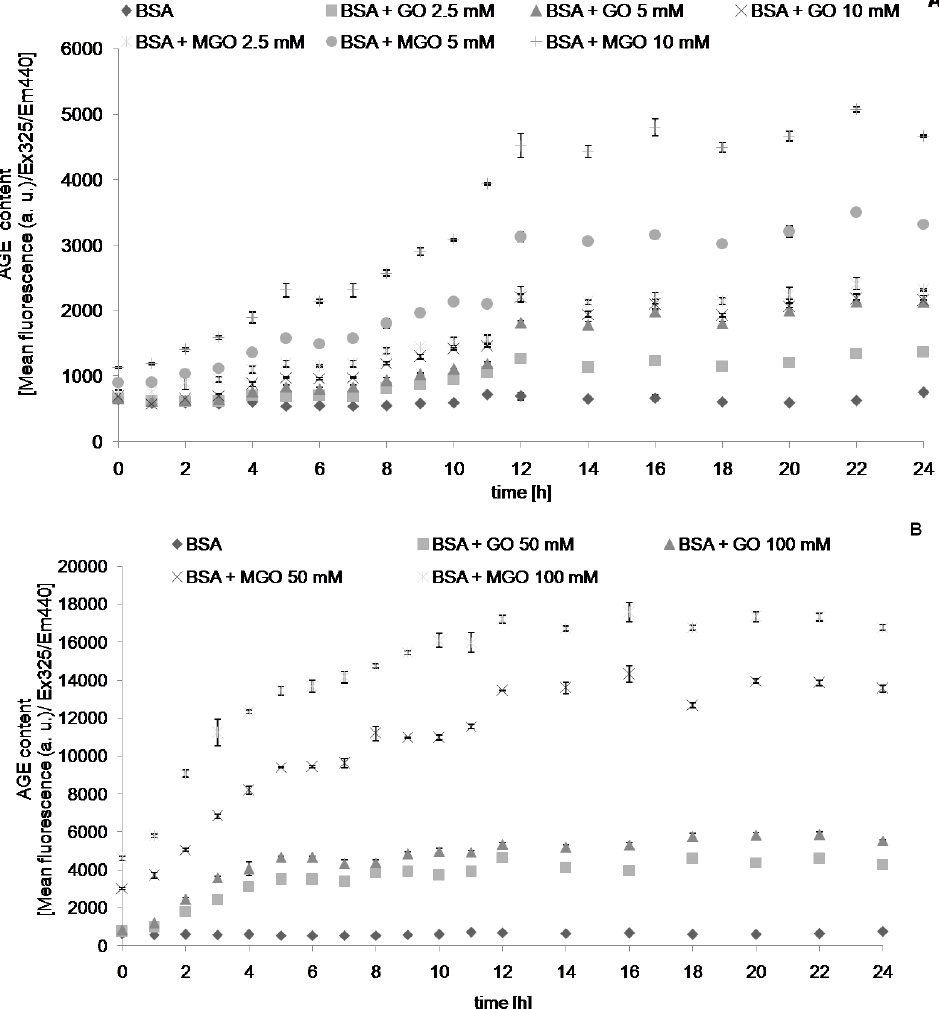
Figure 1. The time course of AGE fluorescence during incubation of BSA (0.09 mM) with 2.5, 5 and 10 mM ( A ), and 50 and 100 mM ( B ) GO and MGO at 37